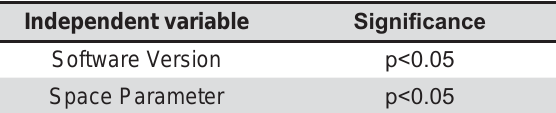
Independent variable (cid:54)(cid:76)(cid:74)(cid:81)(cid:76)(cid:191)(cid:70)(cid:68)(cid:81)(cid:70)(cid:72) Software Version Space Parameter